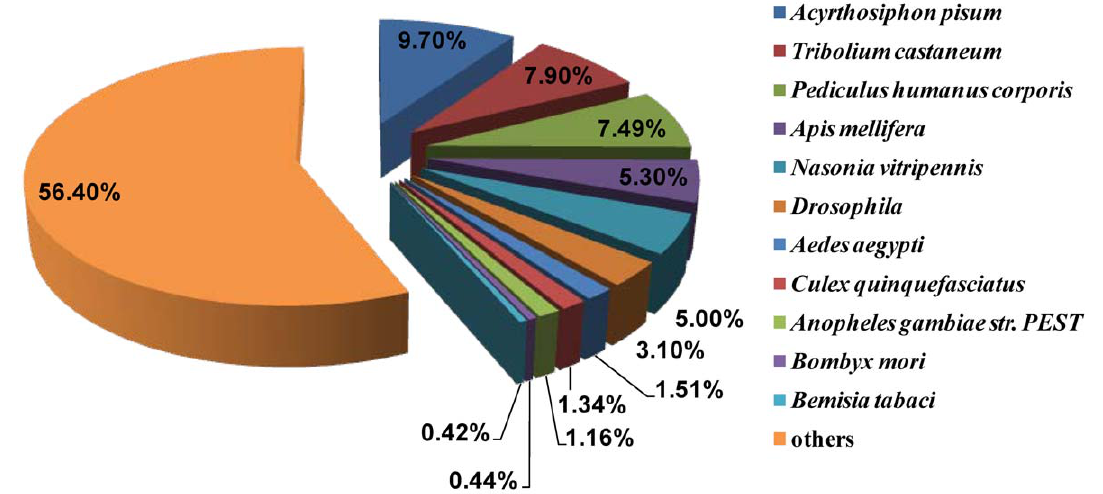
Figure 1. Top BLAST hits of B.tabaci sequences to various insect species. doi:10.1371/journal.pone.0035181.g001 PLoS ONE |